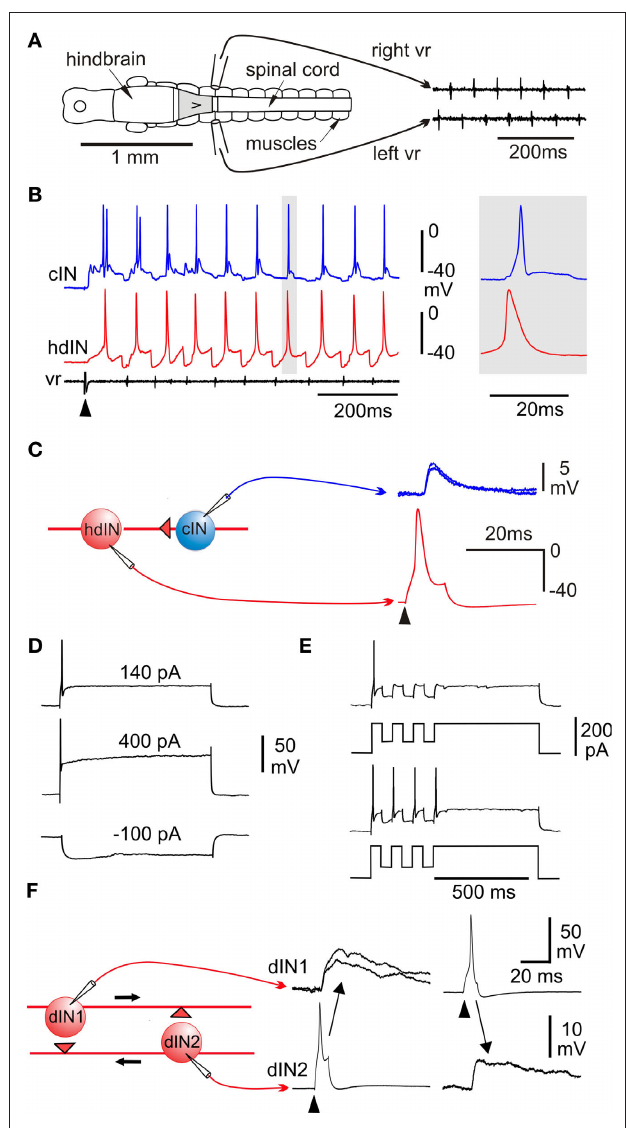
Figure  | Swimming: effects of lesions, activity patterns and excitation. (A) CNS in dorsal view to show suction electrode positions to record alternating ventral root (vr) spikes during swimming generated by an isolated 0.3-mm long region of CNS (gray). (B) Whole-cell recording from a cIN and hindbrain dIN (hdIN) show both fire once on each cycle of swimming and the hdIN has a long action potential; (C) spike evoked in the hdIN by current (arrowhead) leads to an EPSP in the cIN. (D) A dIN fires once to positive current but does not fire on rebound after negative current. (e) If large enough, negative current pulses during depolarization can lead to post- inhibitory rebound firing. (F) Recording from a pair of dINs in the hindbrain shows that when current is injected to make them fire (arrowheads) they produce long duration excitation in the other. (based on Li et al.,